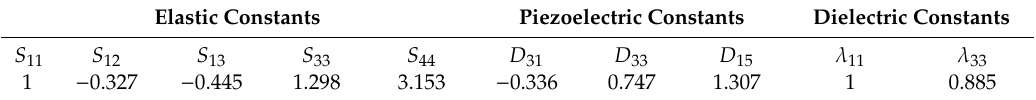
Figure 3. Note that all stress components in Figure 3 are given in dimensionless values (please refer to Equation (15b)). Table 2. Dimensionless physical parameters of material PZT-4.